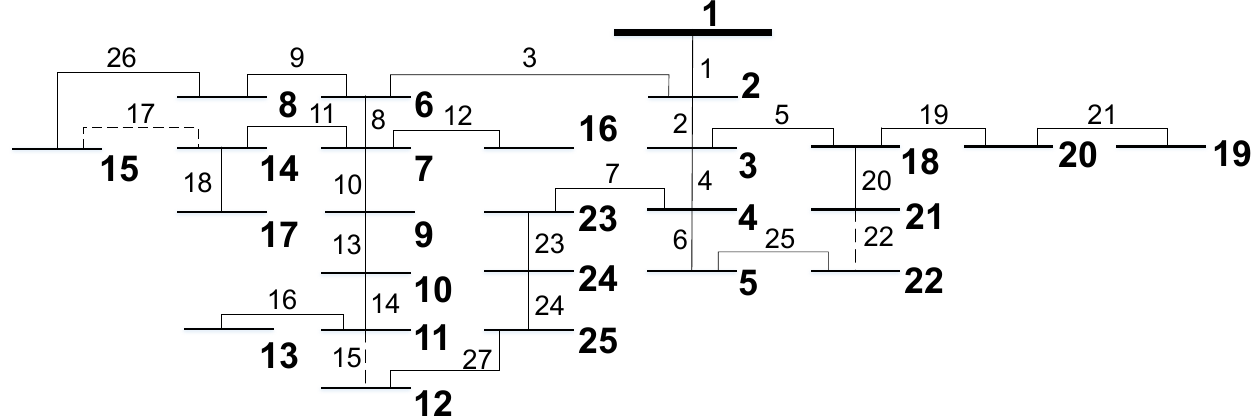
Figure 15. 25-bus and 27-branch